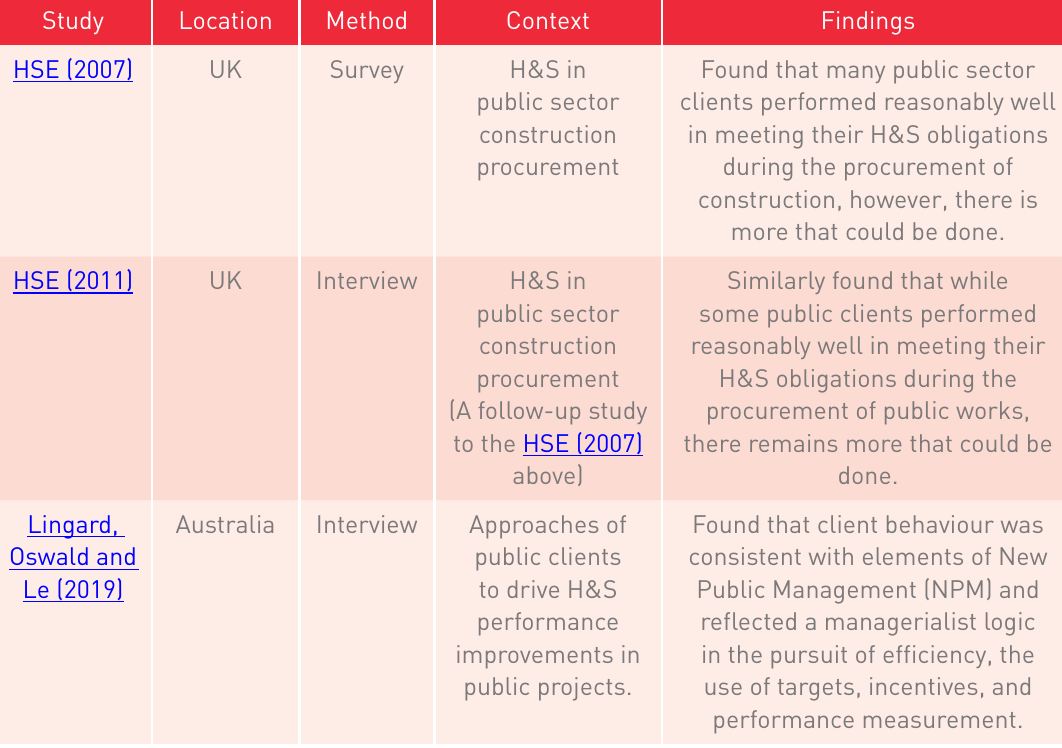
Summary of studies on H&S in public works